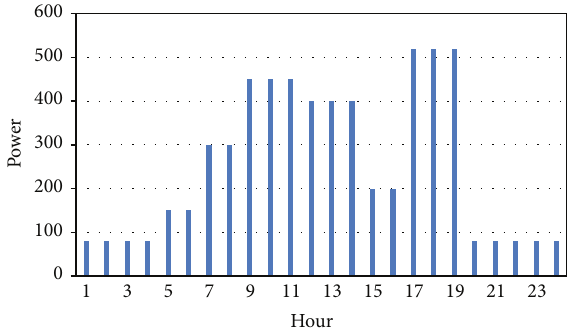
Figure 4: Simulated load